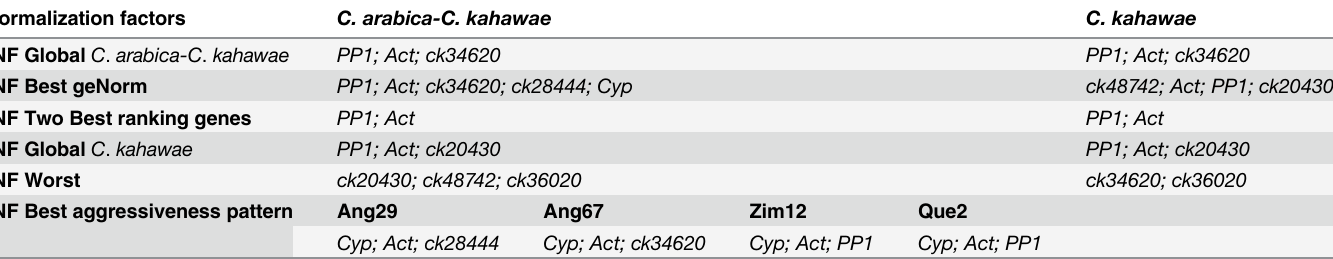
Table 4. Normalization factors tested for gene expression analysis referring to the candidate reference genes included for each sample type. Normalization factors